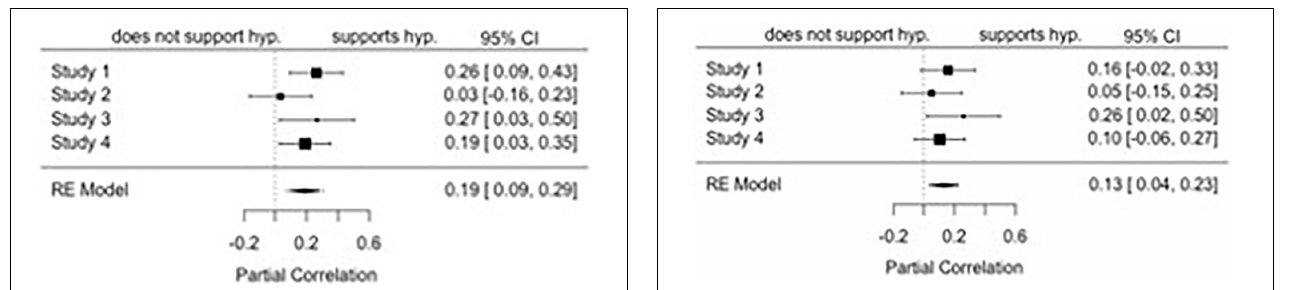
FIGURE 2 | A forest plot of the meta-analyzed two-way interaction between affective attraction and attitude strength on affiliative willingness. relatively low in strength-related properties (-1 SD), affective attraction did not significantly predict affiliative willingness, r = 0.16, p = 0.08, 95% CI: [-0.02, 0.35]. There was significant heterogeneity of effect sizes across studies, Q (3) = 10.33, p = 0.02. However, when attitudes were relatively high in strength-related properties (+ 1 SD), there was a stronger relation between affective attraction and affiliative willingness, r = 0.46, p < 0.001, 95% CI: [0.30, 0.62]. There was again significant heterogeneity of effect sizes across studies, Q (3) = 14.39, p = 0.002.